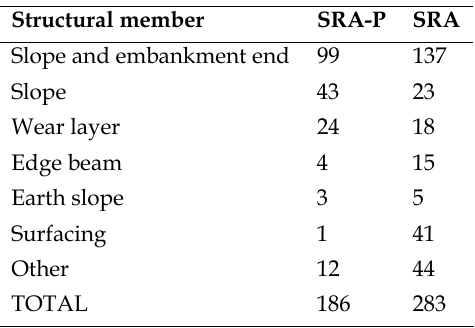
Table 5. The most common types of defects detected by SRA-P and SRA during 2005 sorted by structural